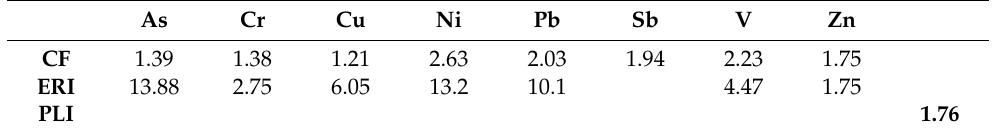
Figure 5. Average enrichment factors (EFs) for the analyzed elements in lichen samples from the survey area. The dashed line indicates the boundary between enriched and non-enriched elements. Table 4. Contamination Factor (CF), Ecological Risk Index (ERI), and Pollution Load Index (PLI) of selected trace